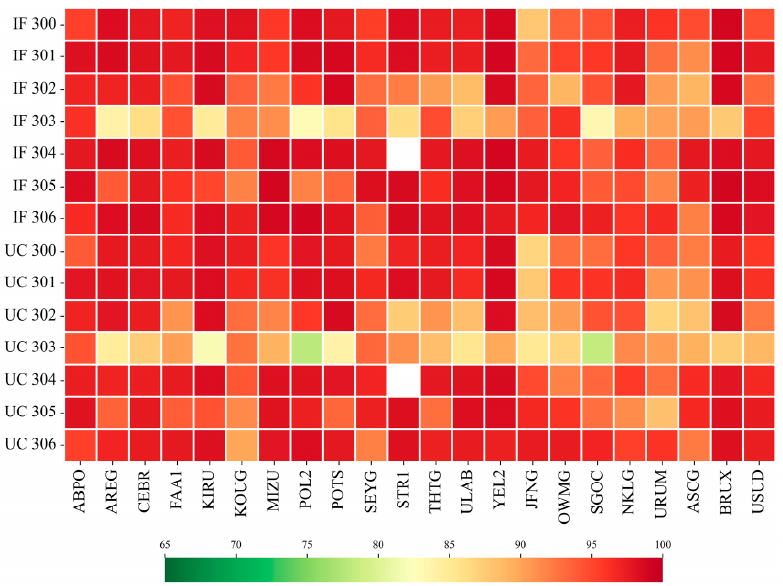
Figure 14. The fixed-ambiguity success rate of GCE static PPP for the IF model and the UDUC model on DOY 300–306, 2021, for 22 stations.